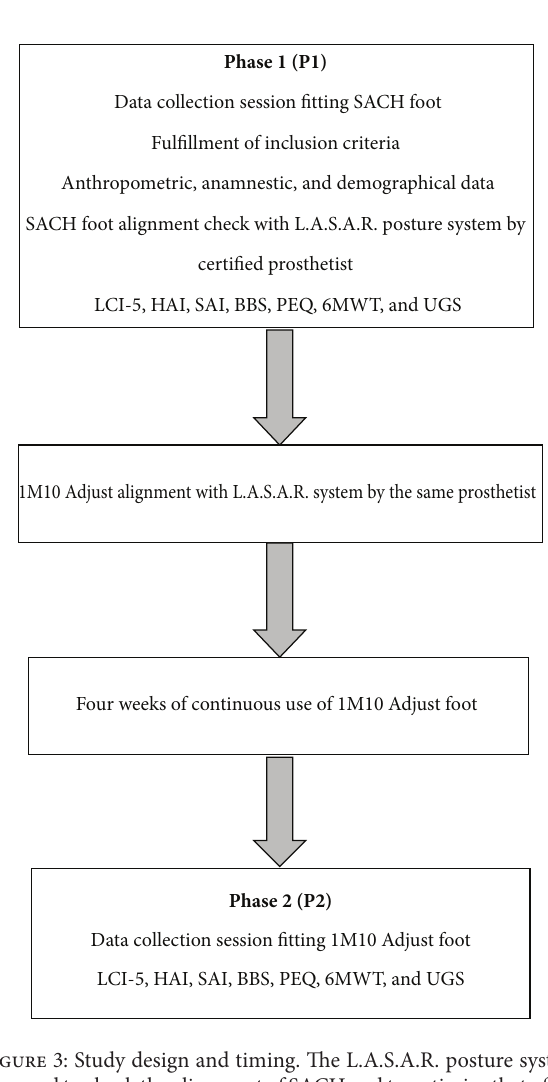
Figure 3: Study design and timing. The L.A.S.A.R. posture system was used to check thealignment of SACH and to optimize that of the 1M10 Adjust by the same certified prosthetist. Outcome measures of Locomotor Capability Index-5 (LCI-5), Hill Assessment Index (HAI), Stair Assessment Index (SAI), Berg Balance Scale (BBS), Prosthesis Evaluation Questionnaire (PEQ), Six-Minute Walking Test (6MWT), and Upright Gait Stability (UGS) were collected fitting SACH during the first phase of evaluation (P1) and 1M10 Adjust foot after one month of acclimation (P2).